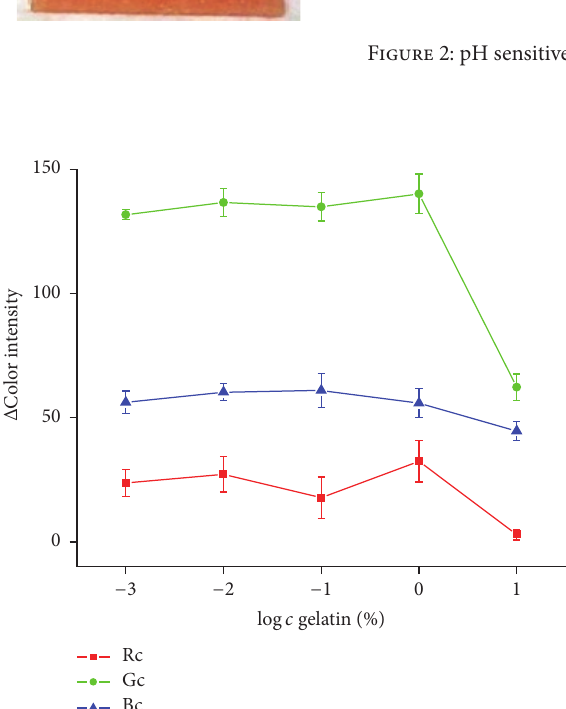
Figure 3: Gelatin optimization. Drop in Δ Color intensity indicates that pH strip did not change into red color. Error bars represent standard error of the mean for 𝑛 = 3. Rc = red channel, Gc = green channel, and Bc = blue channel.